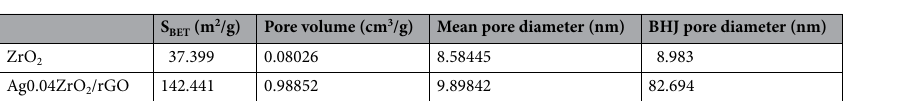
Table 1. Summary of the specific surface area, pore volume, mean pore diameter and BHJ pore diameter is presented the